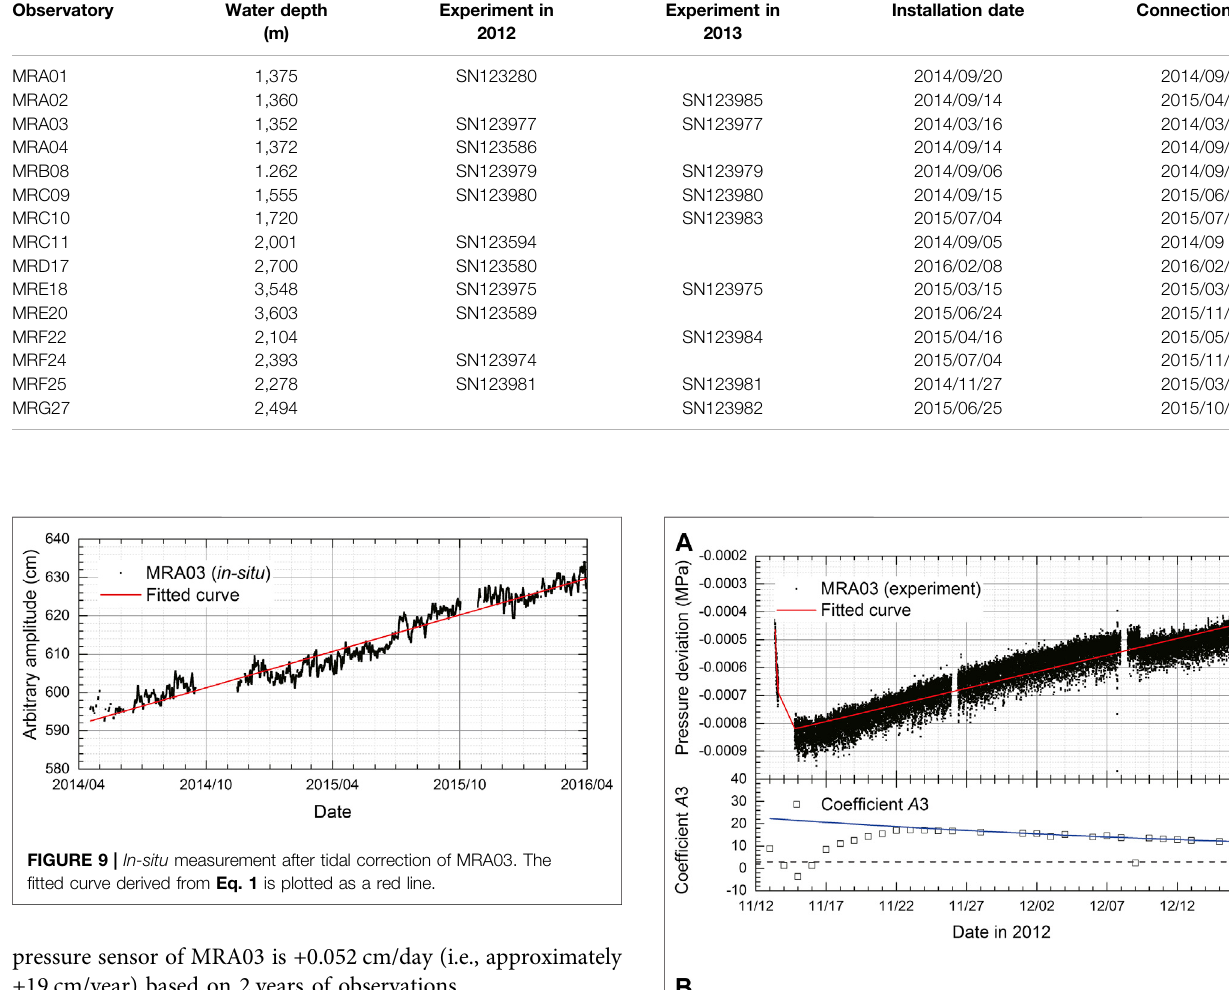
TABLE 1 | Information of DONET pressure sensors and installed/connected date to the observatories. Observatory Water depth (m)